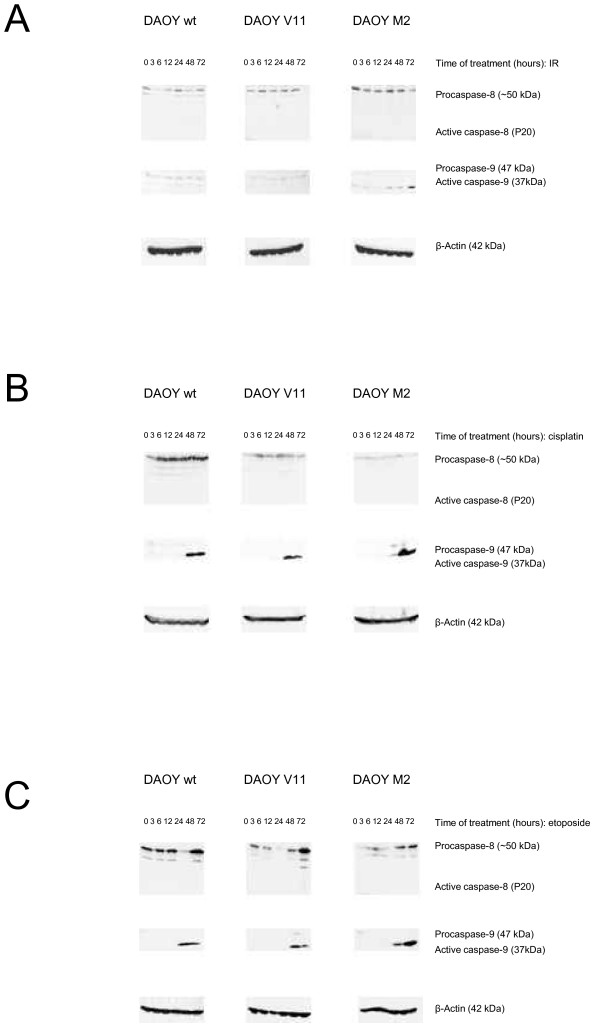
c-MYC expression modulates caspase-9 activation after IR, cispatin, and etoposide treatment of DAOY MB cells. IR (A) triggers caspase-9 cleavage exclusively in c-MYC over-expressing DAOY cells. Caspase-9 cleavage is more pronounced in DAOY M2 cells following treatment with cisplatin (B), or etoposide (C). Cells were irradiated with 5 Gy, treated with cisplatin (0.15 μg/ml) or with etoposide (0.19 μg/ml). Lysates were analyzed at the indicated time points by Western blotting for caspase 8 and 9, and β-actin. Representative blots (two independent experiments) are shown.